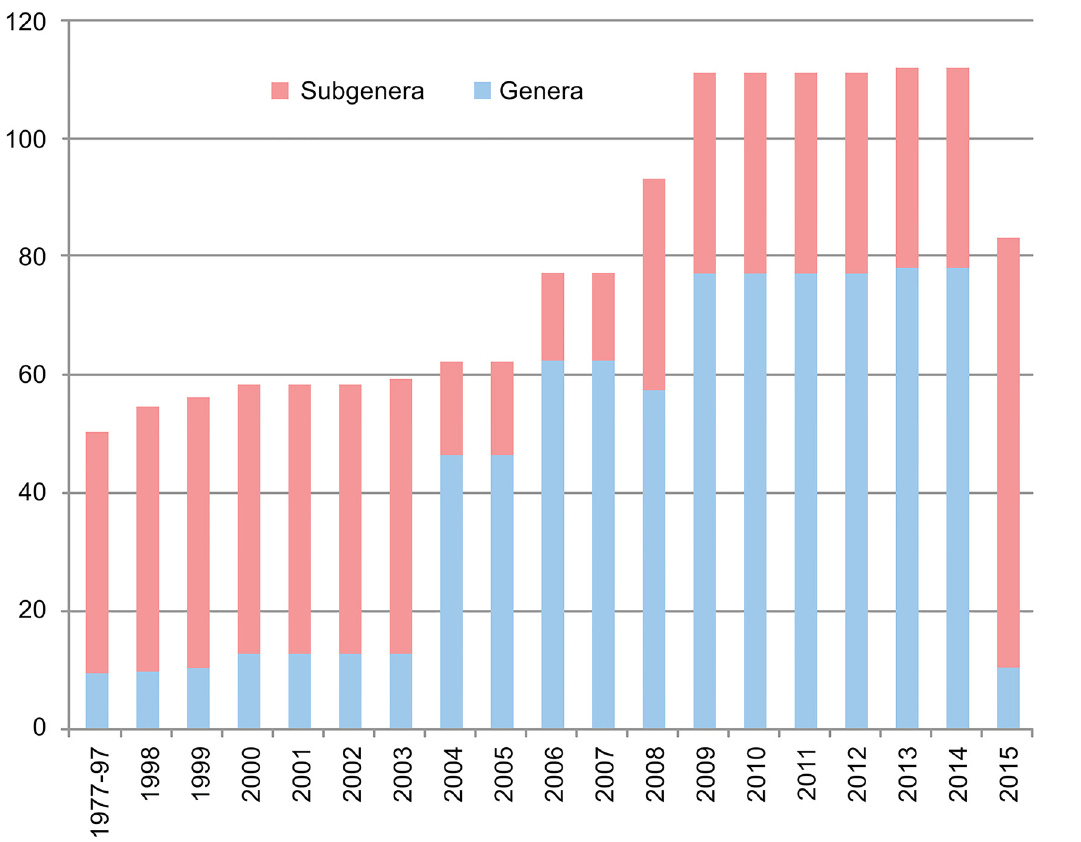
Fig 1. Graph comparing number of aedine mosquito genera and subgenera from 1977 to